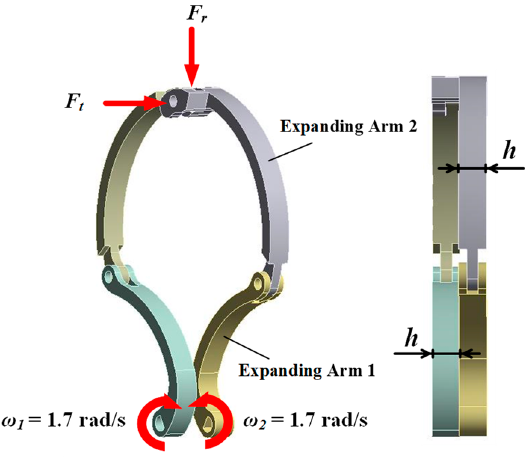
Figure 10. Load applied to the expanding arm.